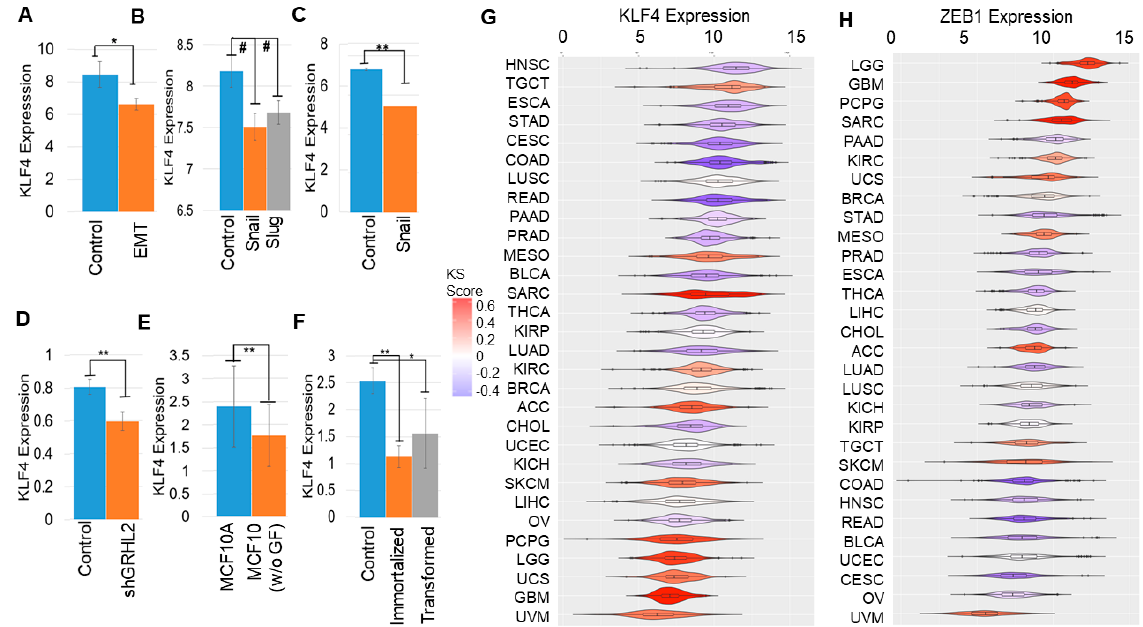
Figure 3. KLF4 is inhibited during EMT. KLF4 expression across comparison groups in GEO datasets. ( A ) GSE59922, ( B ) GSE40690, ( C ) GSE58252, ( D ) GSE118407, ( E ) GSE85857, and ( F ) GSE110677. #: p < 0.1, *: p < 0.05, and **: p < 0.01 for a Student’s two-tailed t -test with unequal variances. ( G , H ) KLF4 and ZEB1 expression in TCGA types, arranged by mean KS scores (color scheme given on the right).